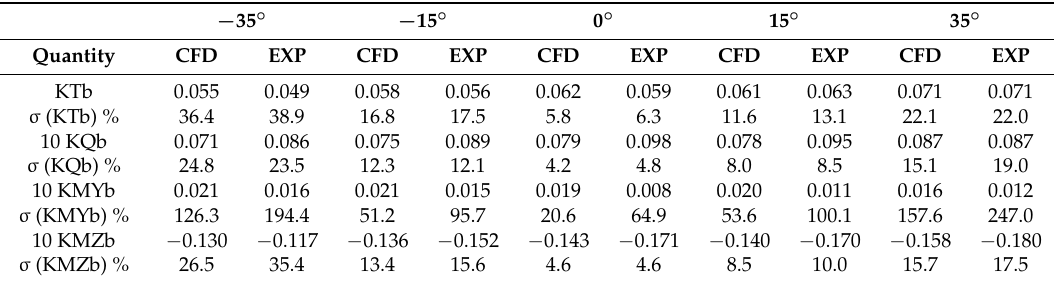
Figure 17. Computed velocity fields on the control plane upstream of the propeller at J = 0.6 for positive and negative heading angles: ( a ) +35 degrees; ( b ) − 35 degrees. View from downstream. Table 4. Measured and computed single blade loads at J = 0.6 for different heading angles.